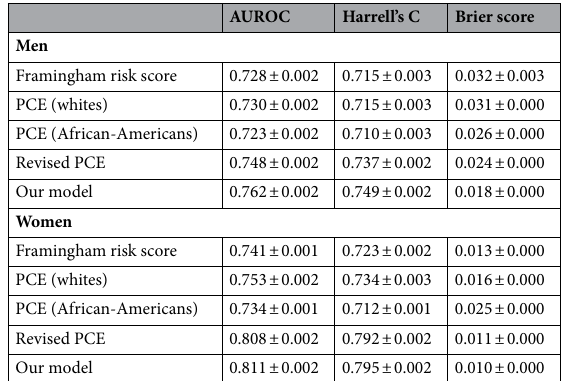
Table 3. Results of tenfold cross-validation of Harrell’s C-index, the area under the receiver-operator characteristic curve (AUROC), Brier score for the pooled cohort equation (PCE), and our model. The mean ± standard